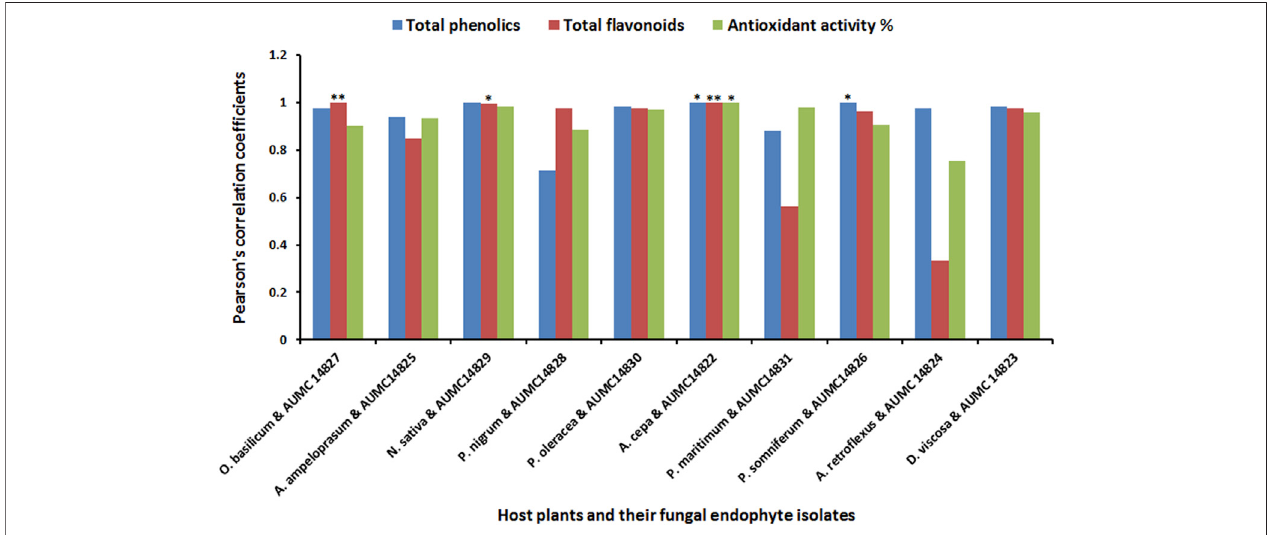
FIGURE 2 | Pearson ’ s correlation coef fi cients of total phenolics, fl avonoids, and the antioxidant activities of different extracts from black seed plants and their mycoendophytic isolates.